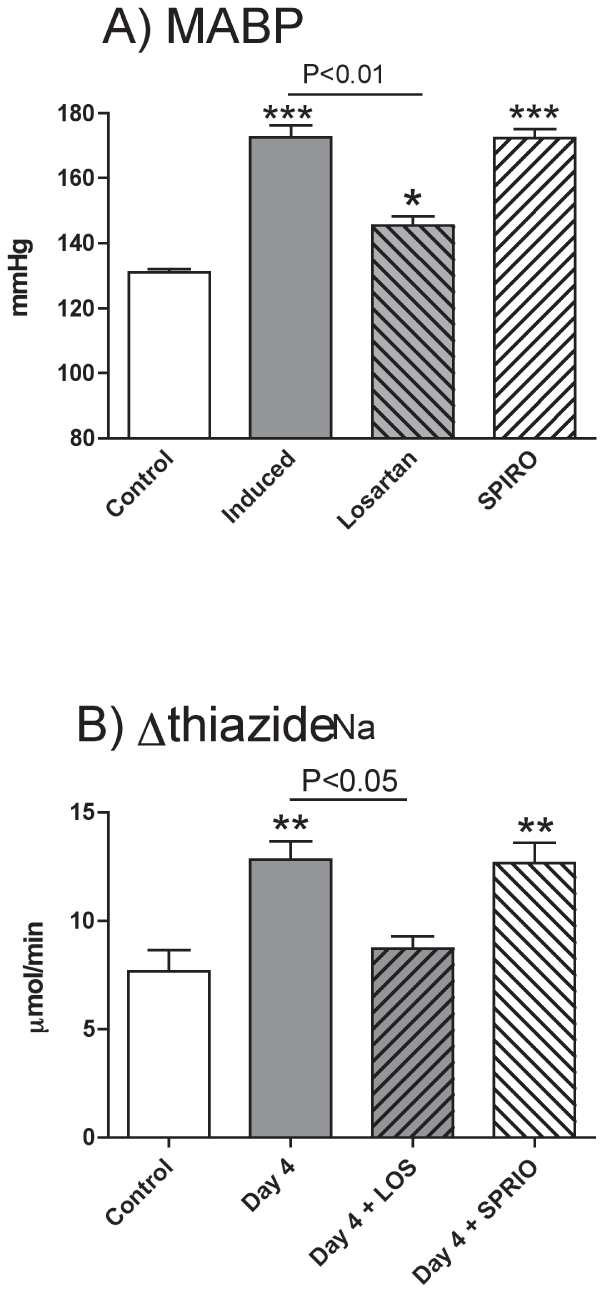
Contributions to hypertension of AT1 and mineralocorticoid receptors.A) Mean arterial blood pressure (MABP) and B) hydrochlorthiazide-sensitive sodium reabsorption (ΔthiazideNa) in cyp1a1-Ren2 transgenic rats. Measurements were made in cyp1a1-Ren2 transgenic rats, anaesthetized on day 4 of the experimental regimen. The first control group (n = 6; open bars) received vehicle, the second control group (n = 8; grey bars) received I3C to induce the Ren2 transgene. Experimental groups received I3C and either losartan (n = 6; grey hatched bars) or spironolactone (n = 6; open hatched bars). Data are means ± SE and statistical comparisons were made using ANOVA with Bonferroni post-test. ***P<0.001, **P<0.01, *P<0.05 versus the non-induced control group and other comparisons as stated.